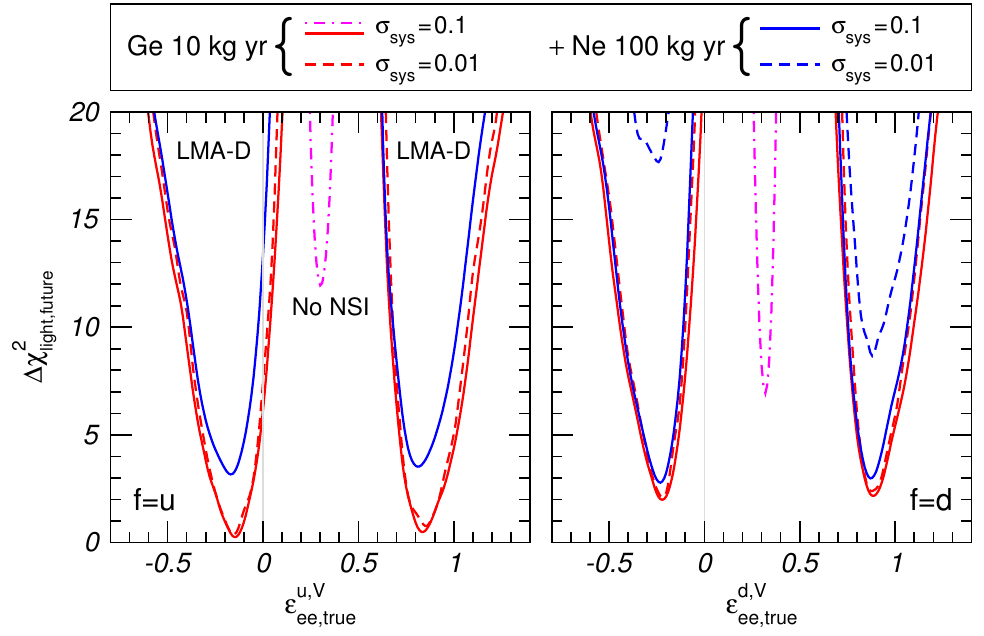
Figure 8 . The full and dashed lines show (cid:1) (cid:31) 2 (LMA-D) from a combination of current oscillation min and future COHERENT data (for di(cid:11)erent assumptions on target and systematics as labeled) as a function of the assumed value of (cid:15) q;V . All other true values used to generate COHERENT data ee; true are set to the current best (cid:12)t point from oscillations. To determine the minimum of the joint (cid:31) 2 in the LMA-D region all oscillation and NSI parameters are varied. The dash-dotted curve shows the (cid:1) (cid:31) 2 for no-NSI under the same assumptions for our default COHERENT con(cid:12)guration.